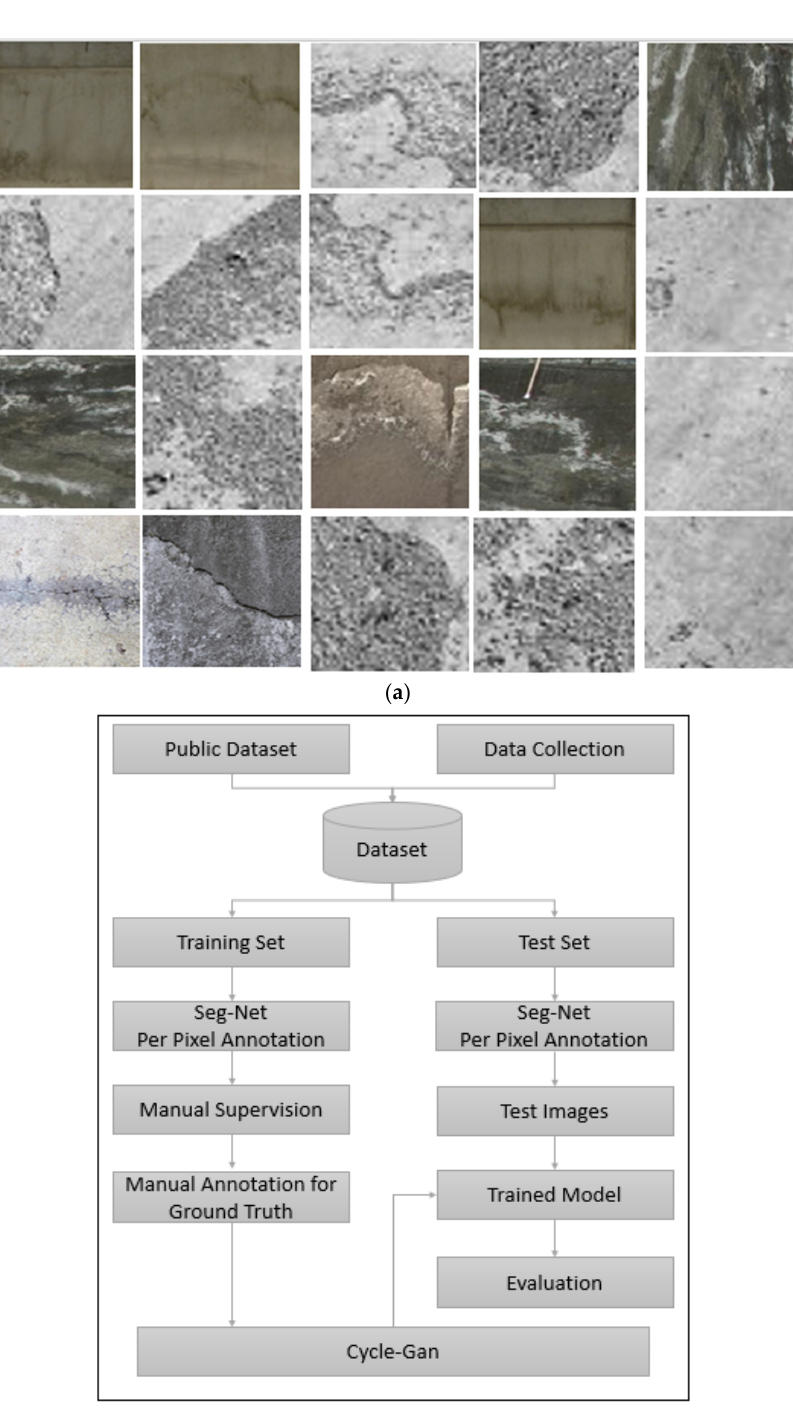
Figure 2. ( a ) Images collected from the selected locations. ( b ) The structure degradation detection framework used in the current